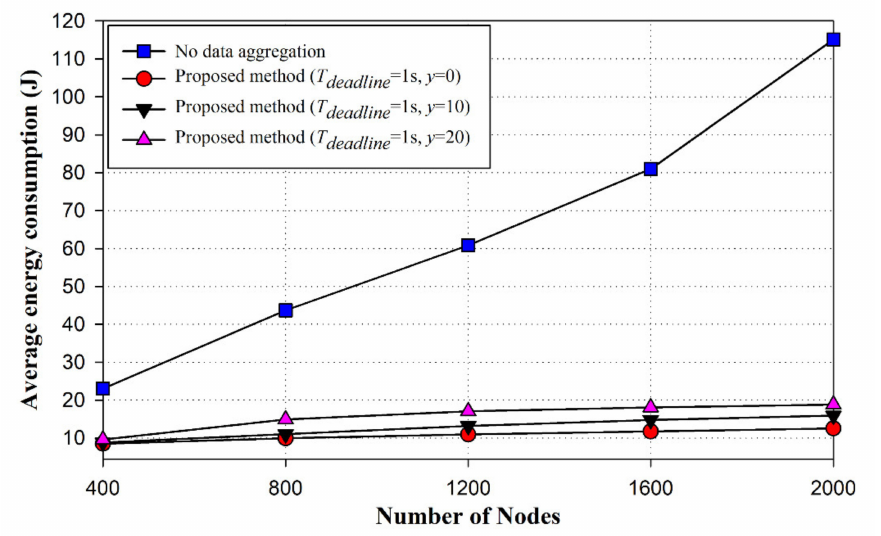
Figure 9. Average energy consumption according to the number of sensor